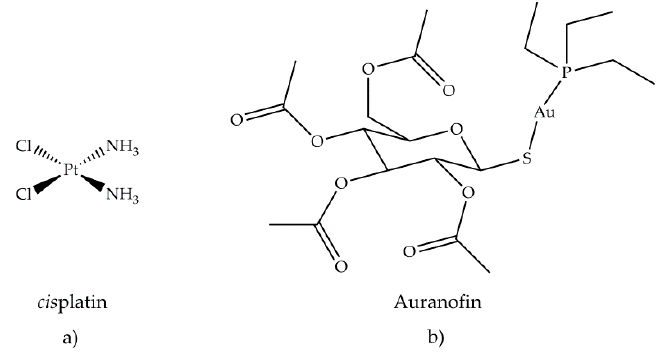
Figure 8. Chemical structure of ( a ) cis platin and ( b ) auranofin. A good cytotoxic activity was also evaluated in vivo against P388 lymphocytic leukemia implanted in mice [81]. Several gold (I) thiolates have been tested for their anticancer activity. Aurothioglucose (Figure 9a) and aurothiomalate (Figure 9b) inhibited primary tumor growth in mice with Lewis carcinoma and reduced lung metastases [81]. Unlike cis platin (6), aurothiomalate did not exhibit acute toxicity in vivo.